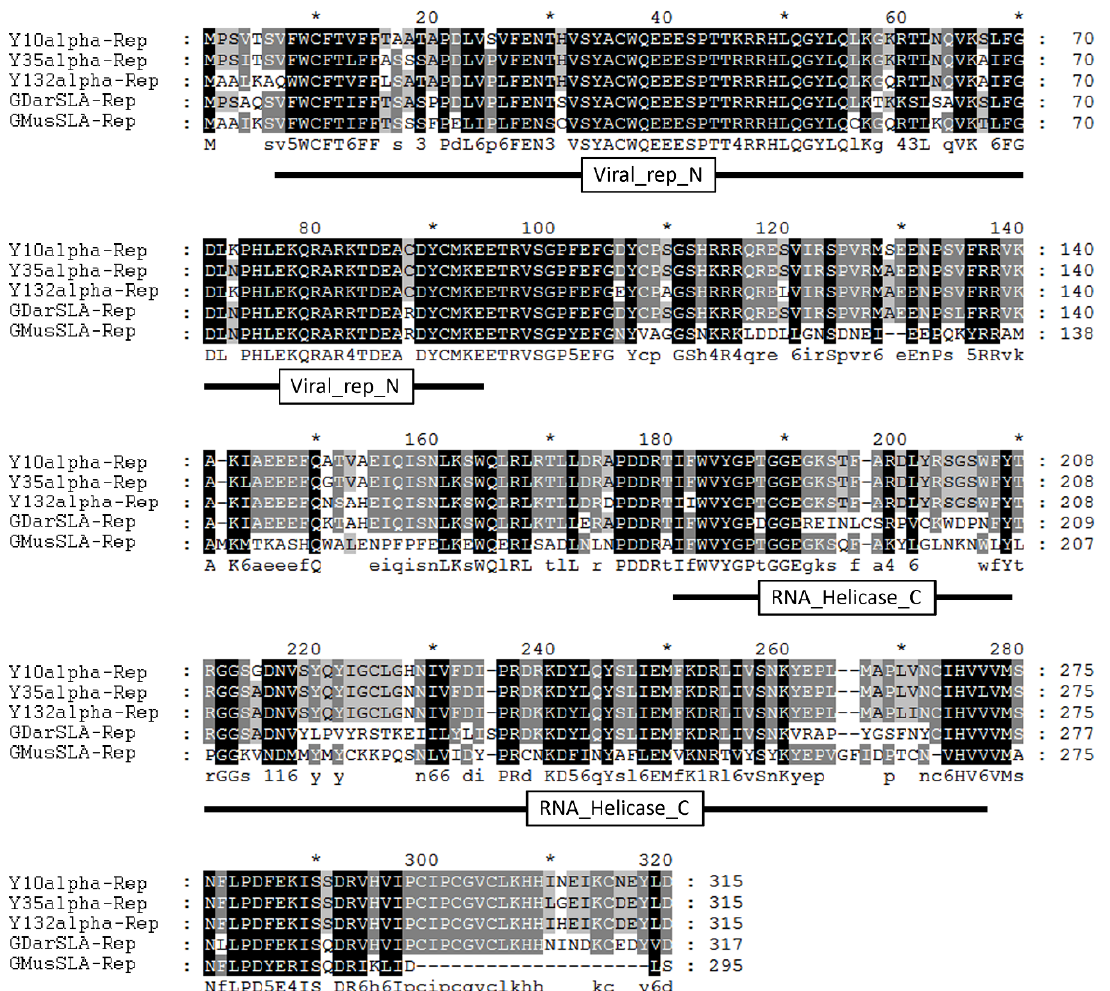
Figure 1. Sequence analysis of alpha-Reps. Amino acid sequence alignment of alpha-Reps of Y10 alphasatellite (AJ579353), Y35 alphasatellite (AJ579345), Y132 alphasatellite (AJ579349), GDarSLA ( Gossypium darwinii symptomless alphasatellite, NC_013013), and GMusSLA ( Gossypium mustelin- ium symptomless alphasatellite, NC_013012). Positions with strictly conserved amino acids are highlighted in black, conserved substitutions in dark gray, and blocks of similar residues in light gray.